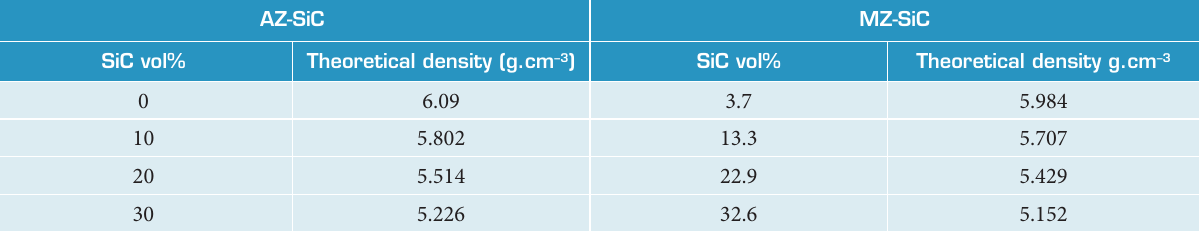
Figure 3. Relative density of ZrB -SiC composites as a function of SiC content: (a) after CIP compaction; (b) after PLS at 2050 2 Table 2. SiC vol% and theoretical densities of the prepared composites.